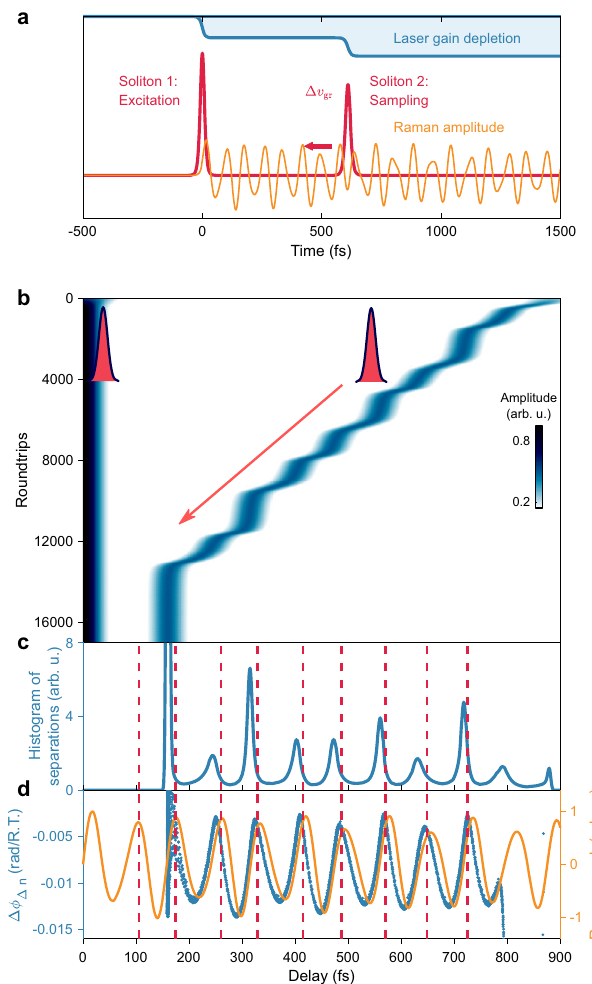
Fig. 3 Simulation of soliton dynamics. a Intracavity Raman sampling is based on the relative motion of two solitons (red) inside an ultrafast laser provided by group velocity differences Δ v gr due to gain depletion (blue) and self-steepening. Soliton 1 excites coherent lattice vibrations (orange) via impulsive simulated Raman scattering. The trailing soliton 2 samples the ultrafast refractive modulation — arising from combined nonlinear electronic and nuclear contributions in the Kerr-lens con fi guration. b Simulated evolution of single-shot autocorrelations as a function of cavity roundtrips during a soliton approach. In correspondence to the experimental observations, the motion progresses via meta-stable steps and fi nally stops at a stable bound-state. c The histogram of separations during the transit reveals meta-stable states, close to stable bound-state separations observed by Kitano et al. (red, Ref. 16 ). d The extracted relative phase τ ð Þ , is differences between two consecutive simulation roundtrips, Δ ϕ Δ n governed by the underlying Raman waveform Fig. 2c, d reveal that the motion decelerates and meta-stable binding occurs at the local maxima of the Raman waveform. Based on the intricate balance of gain saturation, electronic and Raman nonlinearities, our model reproduces this characteristic experi- mental observation, as shown in the simulated autocorrelations and derived histogram in Fig. 3b, c, respectively. We fi nd similar agreement only by including both Raman-induced phase and amplitude modulation, and we employ relative strengths accord- ing to the ratio of electronic self-phase and self-amplitude mod- ulation in Ti:sapphire lasers 30 of 10. In correspondence to the experiments, the motion may not necessarily stop, and upon continued relative motion, the nuclear index modulation changes